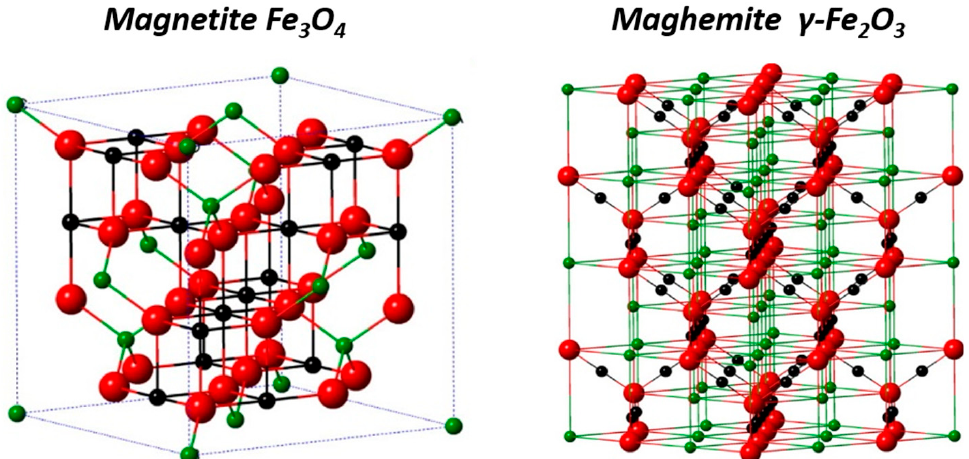
Figure 3. Crystalline structure and crystallographic data of the magnetite (left), and maghemite (right) (the black sphere is Fe 2+ , the green sphere is Fe 3+ , and the red sphere is O 2 − ) [21]. Adapted with permission from [21] under the terms of the CC BY license.